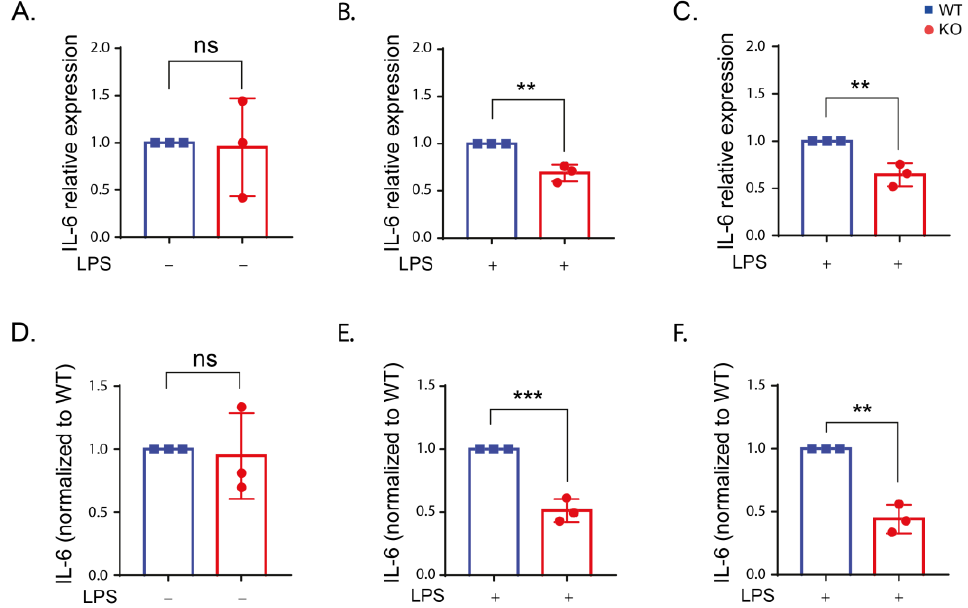
Figure 4. IL-6 expression is reduced in the absence of LRRK2 after LPS stimulation. ( A – C ) IL-6 expression in the WT and KO cells under control conditions ( A ) and after LPS stimulation for 6 ( B ) and 24 h ( C ) using reverse transcription quantitative real-time PCR using β -actin and ribosomal protein L13A (RPL13A) as housekeeping genes. ( D – F ) The amount of IL-6 in the supernatant of the WT and KO cells under control conditions ( D ) and after LPS stimulation for 6 ( E ) and 24 h ( F ) using ELISA assay. The experiment was performed 3 times and t-test was used to compare the average IL-6 expression or level normalized to the corresponding WT. Error bar represents mean ± SD. p -values indicating statistically significant differences between the mean values are defined as follows: ns — not significant, ** p < 0.01, *** p < 0.001.